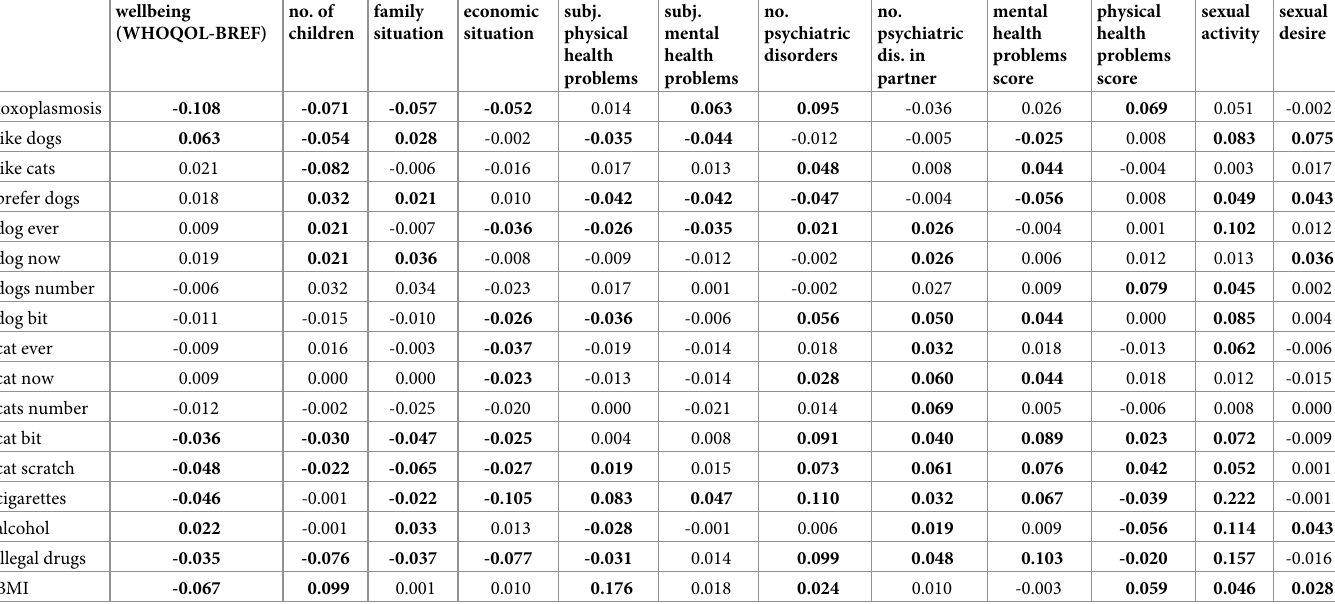
Table 4. Association of animals-related variables with wellbeing and health of male responders. wellbeing (WHOQOL-BREF)